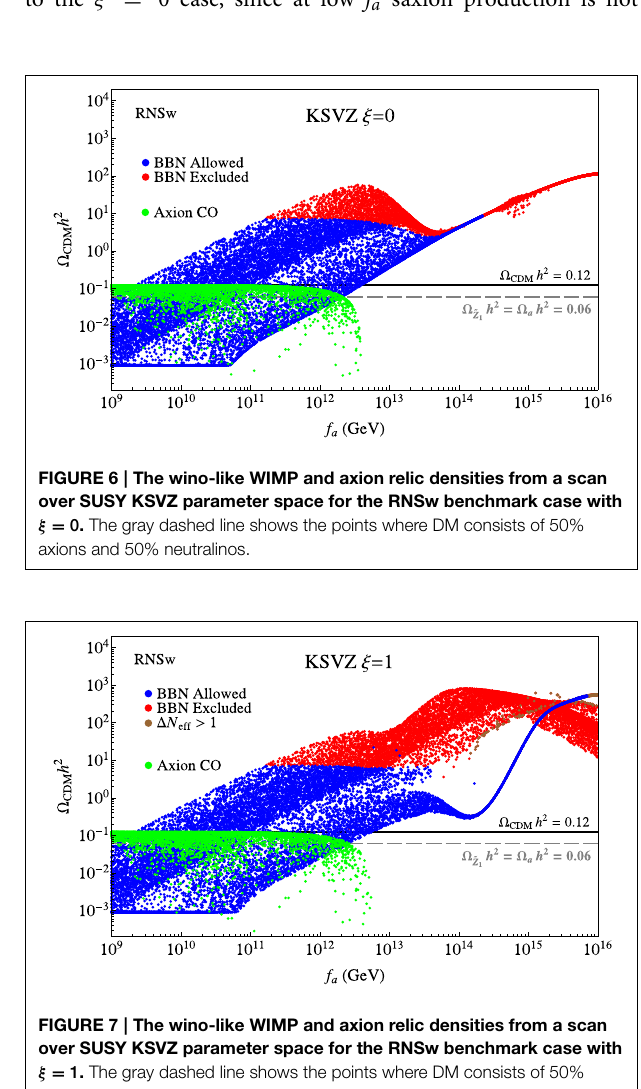
Frontiers in Physics |